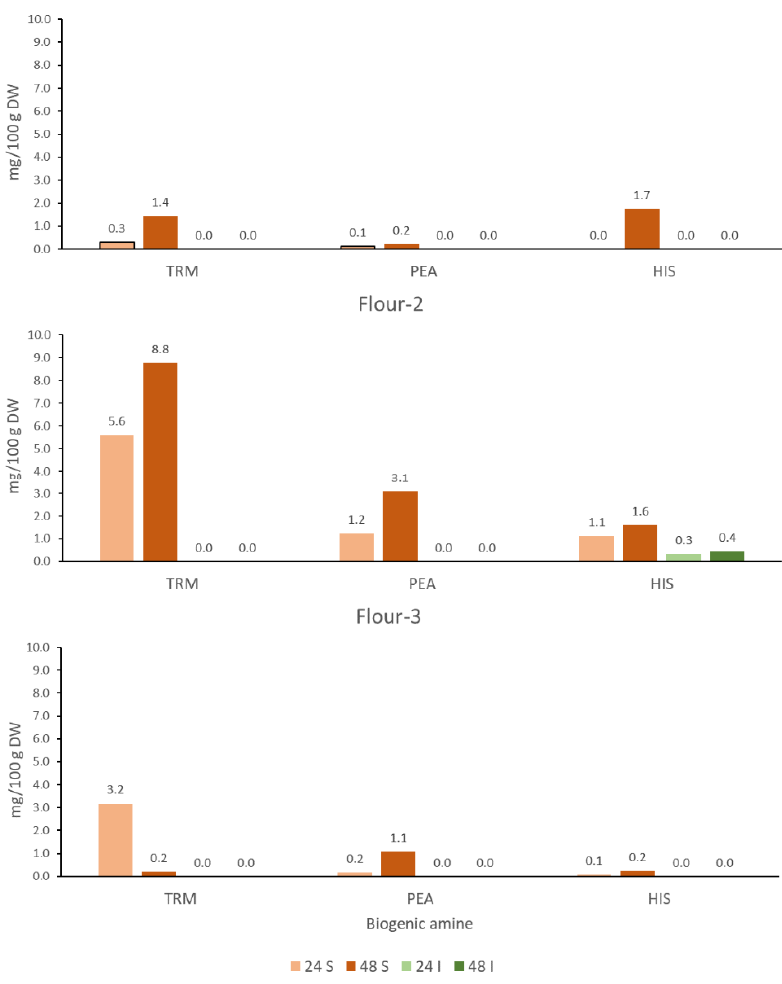
Figure A2. Tryptamine (TRM), phenethylamine (PEA) and histamine (HIS) in chickpea sourdoughs from Flour-1; Flour-2, Flour-3, prepared by spontaneous fermentation (S) and inoculated fermentation with commercially available starter culture (I) after 24 h and 48 h of fermentation at 30 ◦